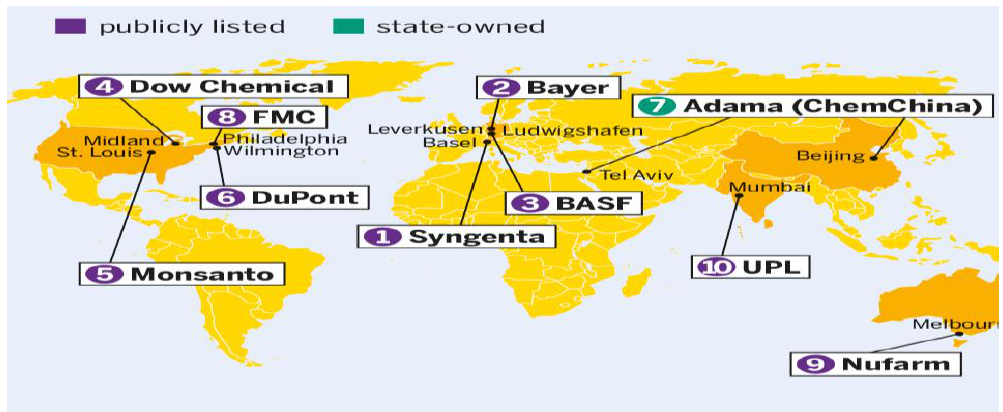
Figure 1 : Top Ten Headquarters Agrochemical Worldwide Companies